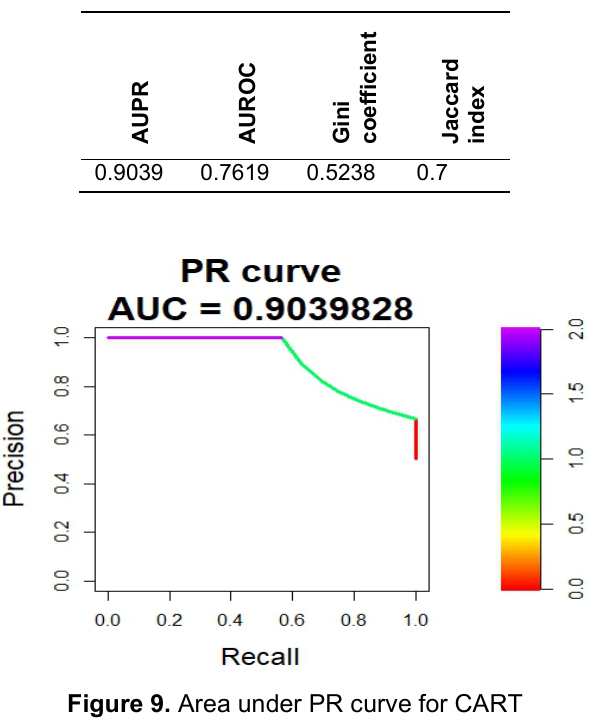
Figure 9. Area under PR curve for CART